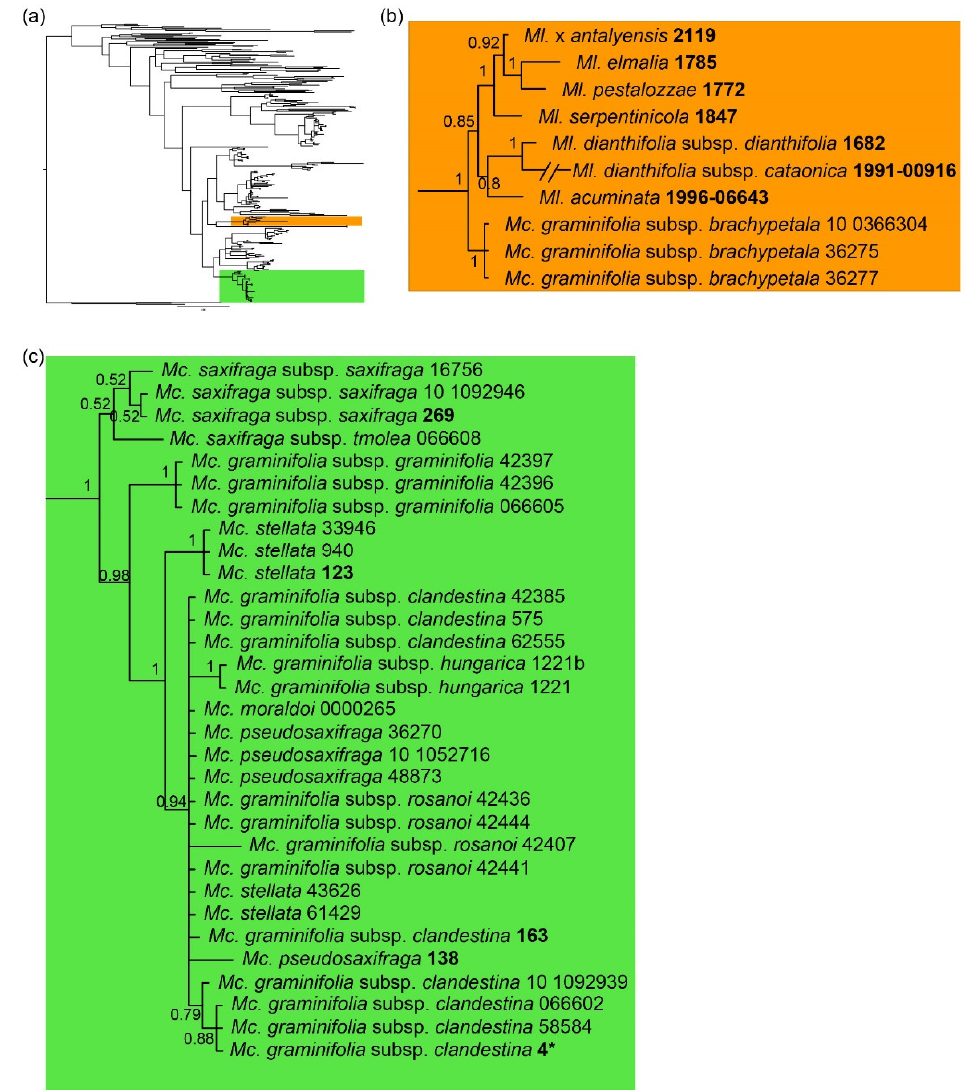
Figure 2. Consensus tree from a Bayesian analysis employing ITS DNA data. Sequences are from the specimens employed by Dillenberger and Kadereit [26], Koç et al. [35], and the present study. ( a ) Outline of the phylogeny of Minuartia s.l. (290 terminals); ( b ) Minuartiella clade; ( c ) Mcneillia clade. In bold: voucher codes of sequences from the literature (see text for references); the sequence labelled as Mc. graminifolia subsp. clandestina 4 (here marked with an asterisk) was reported by Dillenberger & Kadereit [26] as “ Minuartia graminifolia 4”, but reidentified since.